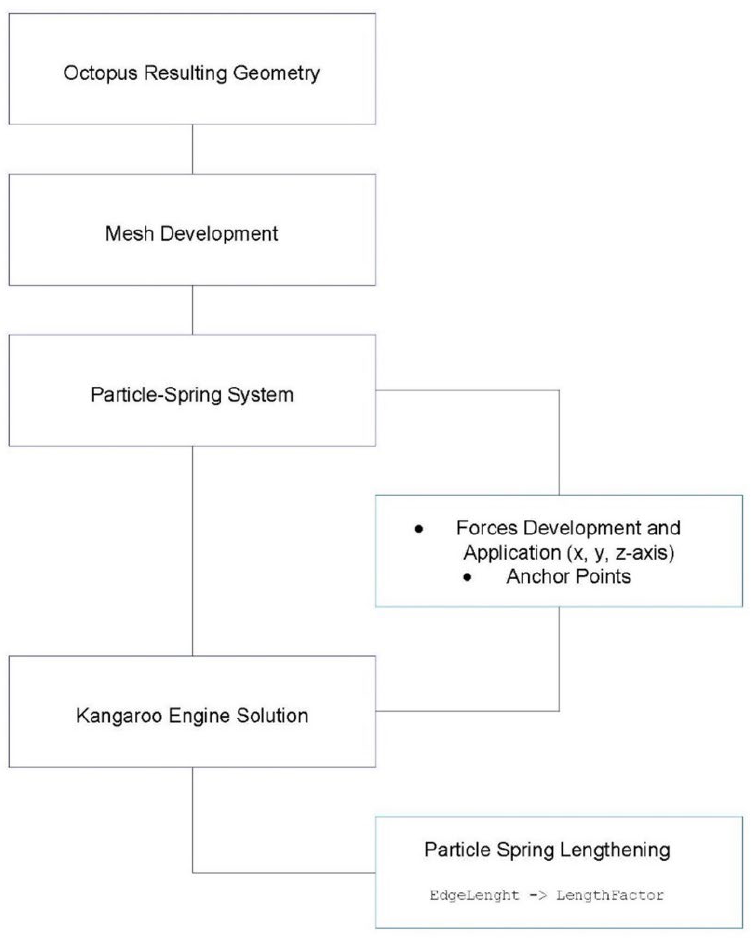
Figure 21. Kangaroo Engine workflow.